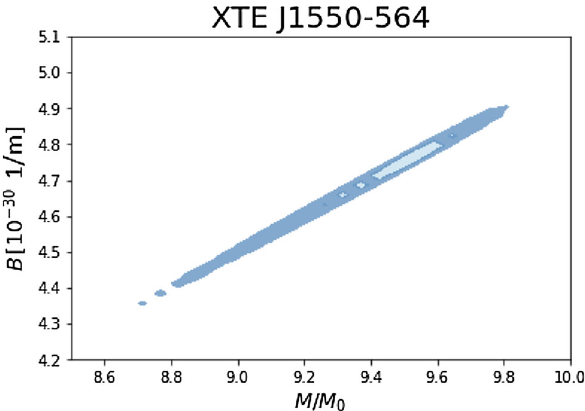
Fig. 10 Plotshowingtheparametricplotofmagneticfield B andblack hole mass between 68% and 95%